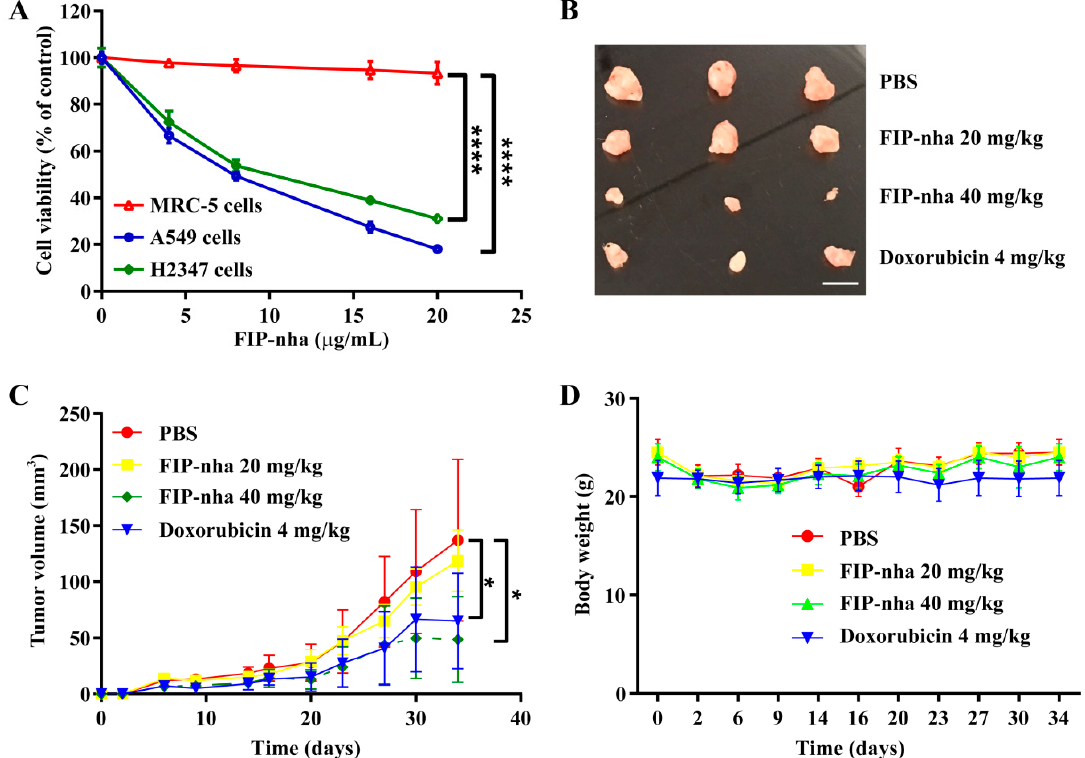
Figure 1. Inhibitory effects of FIP-nha on ex vivo and in vivo lung adenocarcinoma growth. ( A ) Effect of FIP-nha on MRC-5, A549 and H2347 cell growth. The cells were treated with FIP-nha (0, 4, 8, 16, or 20 µ g/mL) for 24 h. Cell viability was measured by MTT assays. **** p ≤ 0.0001. ( B ) Inhibition of solid tumor growth in FIP-nha-treated xenograft mice of A549 cells. Images of solid tumors in negative control (PBS), positive control (doxorubicin, 4 mg/kg body weight) and experimental groups (FIP-nha, 20 and 40 mg/kg body weight) are shown. Each group contained 8 mice. Scale bar = 0.5 cm. ( C ) Effect of FIP-nha on the volume of solid tumors. * p ≤ 0.05 was considered significant. ( D ) Effect of FIP-nha on body weight. Quantitative data are shown as mean ± SD for tumor volume or body weight measurements.